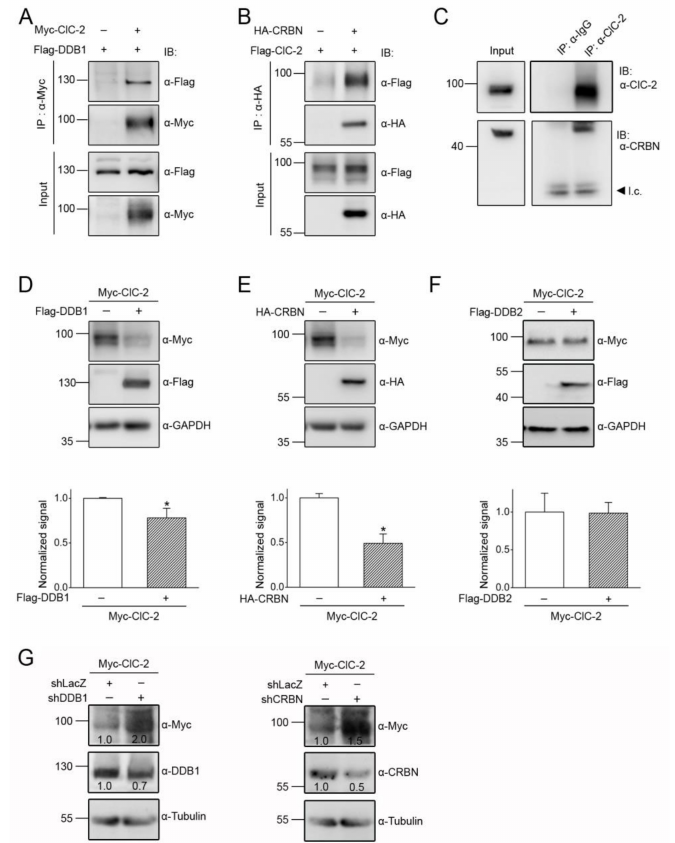
Figure 2. DDB1 and CRBN enhance ClC-2 protein degradation. ( A , B ) Co-immunoprecipitation of Myc-ClC-2 and Flag-DDB1 ( A ), as well as of Flag-ClC-2 and HA-tagged CRBN (HA-CRBN) ( B ), in HEK293T cells. Flag-DDB1 and HA-CRBN were recognized with α -Flag and the anti-HA antibody ( α -HA), respectively. ( C ) Interaction of endogenous CRBN with ClC-2 in the rat brain. Whole brain lysates were immunoprecipitated with the anti-ClC-2 antibody ( α -ClC-2), followed by immunoblotting of the immunoprecipitates with α -ClC-2 or the anti-CRBN antibody ( α -CRBN). Co-immunoprecipitation of CRBN was achieved by using α -ClC-2 but not by rabbit IgG ( α -IgG). l.c.: IgG light chain. ( D – E ) (Upper panels ) Representative immunoblots showing the e ff ect of Flag-DDB1 ( D ) or HA-CRBN ( E ) co-expression on the Myc-ClC-2 protein level. Co-expression with the Flag or the HA vector was used as the control experiment. ( Lower panels ) Quantification of the relative ClC-2 protein levels. Values from the DDB1 or the CRBN co-expression groups ( hatched bars ) were normalized to those for the corresponding vector control ( clear bars ) (*, t test: p < 0.05; n = 7–10). ( F ) ( Upper panel ) Representative immunoblots showing the lack of an e ff ect of Flag-DDB2 co-expression on the Myc-ClC-2 protein level. Co-expression with the Flag vector was used as the control experiment. ( Lower panel ) Quantification of relative ClC-2 protein levels ( t test: p > 0.05; n = 3). ( G ) Representative immunoblots showing the e ff ect of shRNA knockdown of endogenous DDB1 (shDDB1) or CRBN (shCRBN) in HEK293T cells on Myc-ClC-2. Infection with shLacZ was used as the control experiment. The numbers on the immunoblot denote the relative ClC-2 protein